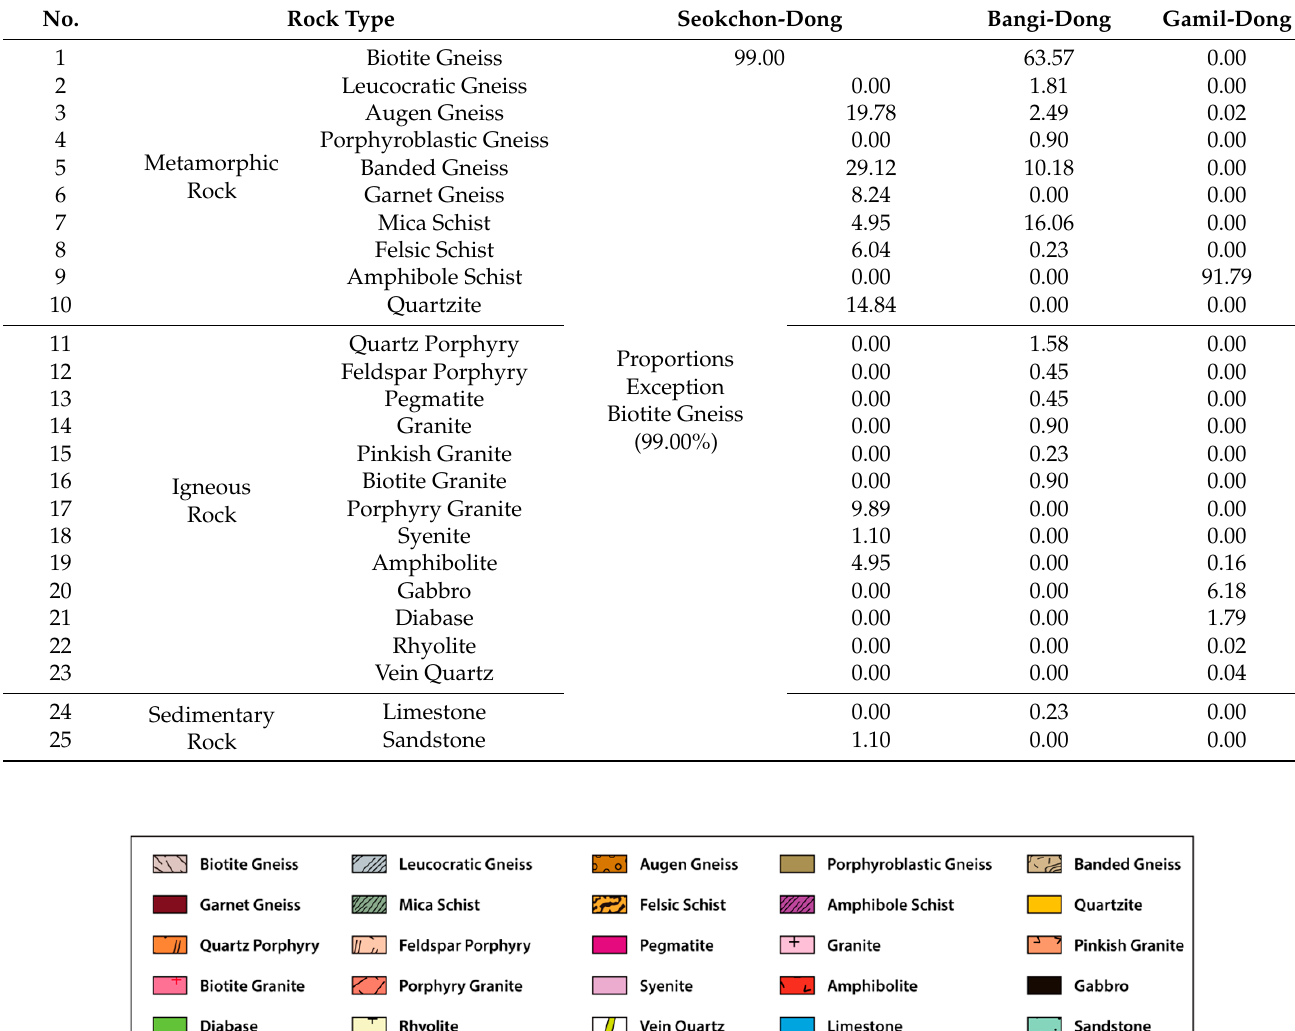
Table 2. Proportions of rock types in each tomb (%).